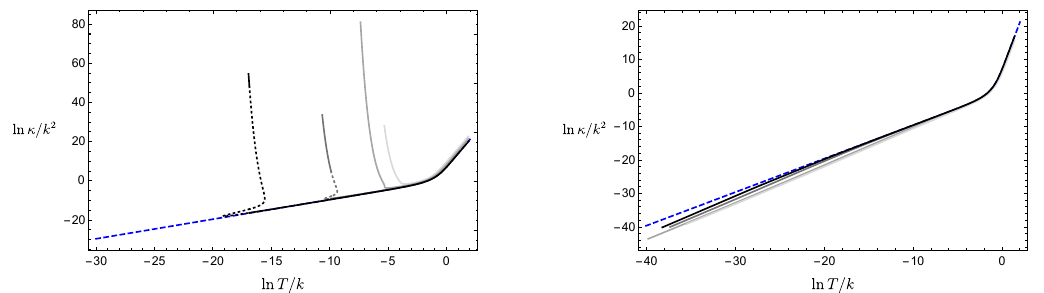
Figure 8 . Plots of the temperature dependence of the thermal conductivity (cid:20) for the black hole solutions constructed for m 2 = (cid:0) 15 = 4 and (cid:24) = (cid:0) 1 = 4. The left plot is for (cid:0) =k 3 = 2 (cid:20) (cid:22)(cid:0) (cid:24) 19 : 37, namely 5 : 5, 10 : 3, 18, and 19 : 3 (light grey to dark grey), as in (cid:12)gure 7, and we see thermal conducting behaviour with (cid:20) ! 1 as T ! 0. The dashed blue line in both plots is for (cid:0) =k 3 = 2 = (cid:22)(cid:0) with (cid:20) (cid:24) T as T ! 0. The right plot is for (cid:0) =k 3 = 2 (cid:21) (cid:22)(cid:0), namely, 19 : 41, 19 : 75, 25 and 35 (dark grey to light grey), as in (cid:12)gure 7, and we see thermal insulating behaviour with (cid:20) ! 0 as T !